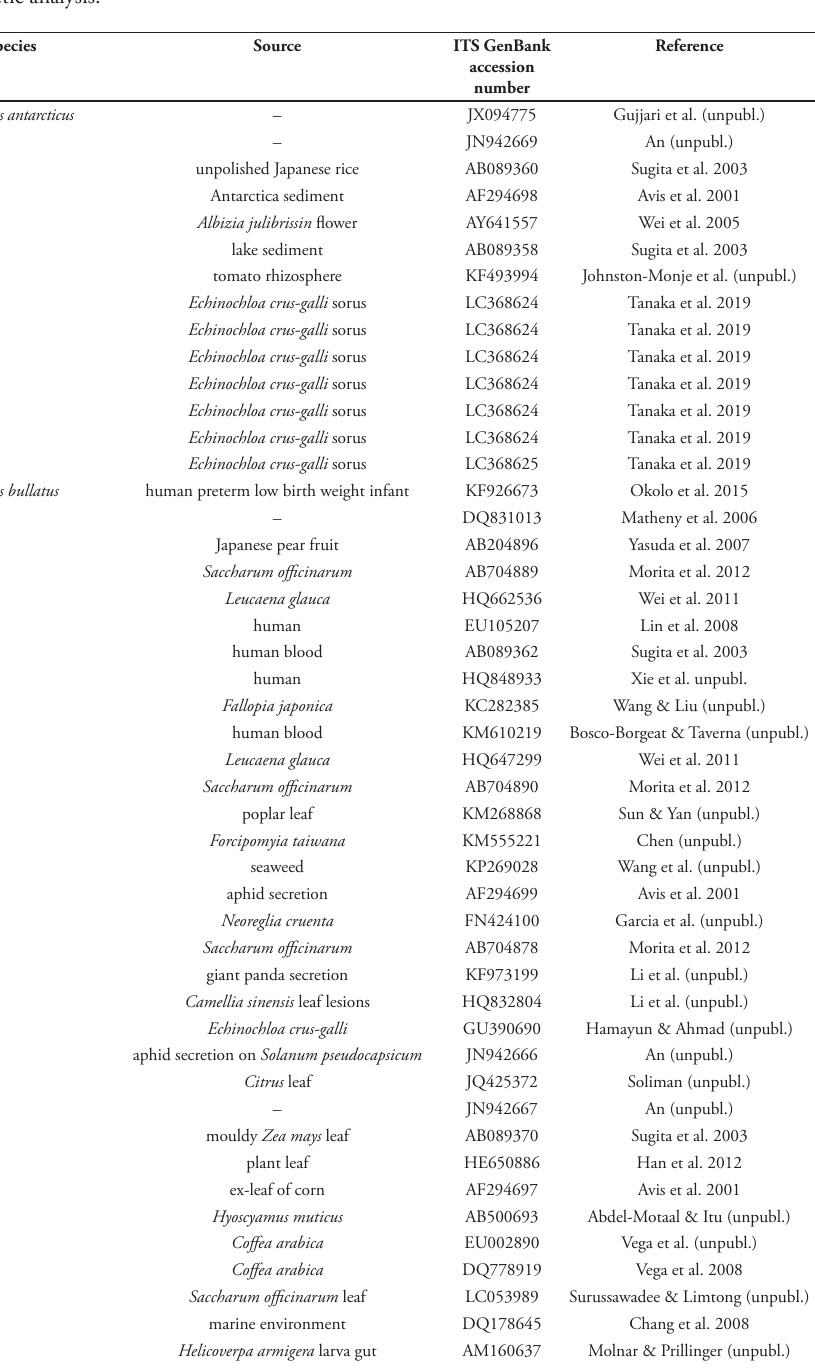
Table 2. List of Moesziomyces , Triodiomyces , and Ustilago sequences taken from GenBank and used in the phylogenetic